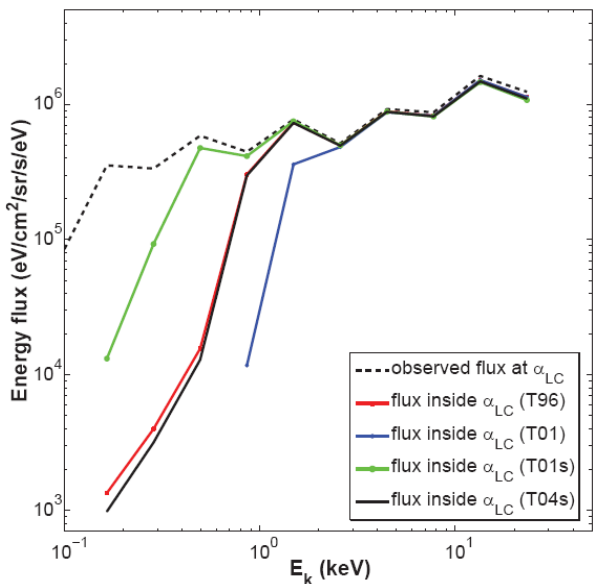
Fig. 7. Estimate of precipitation electron energy flux inside the loss cone as a function of kinetic energy color-coded for use of different Tsyganenko magnetic field models, based on the loss cone filling index profiles and a typical dayside electron distribution around the loss cone observed by the THEMIS ESA instrument at L = 9.5 under a similar low geomagnetic condition (dotted curve).